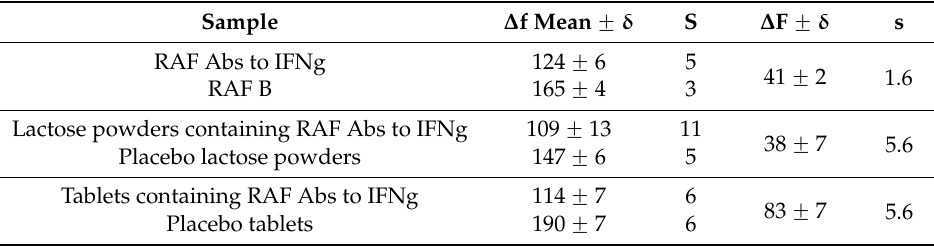
Table 1. Repeatability (intra-assay precision): evaluation of net signals obtained for target samples vs. control.